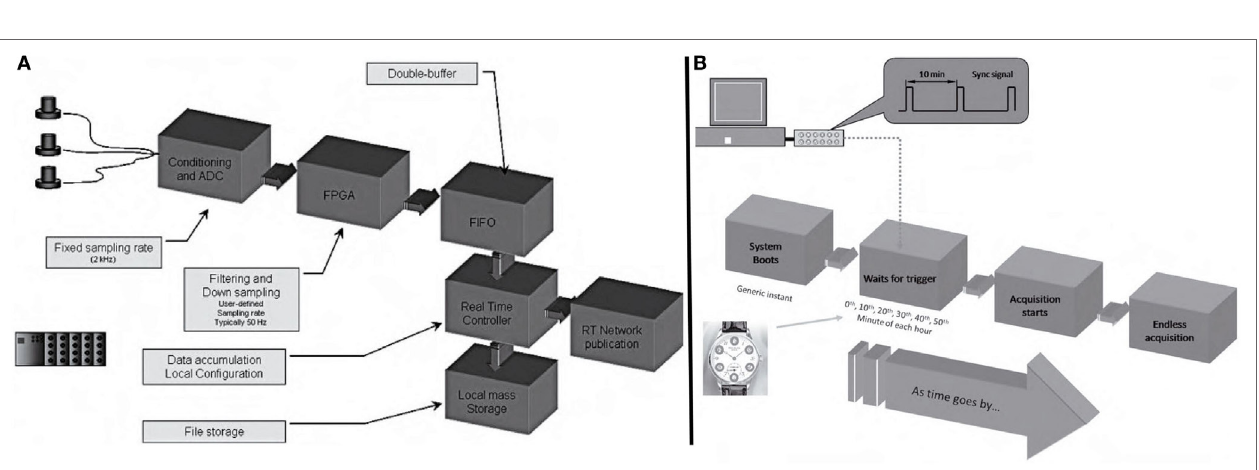
FiGURe 12 | (A) Representation of the network system and (B) sensors deployed in the stadium. Reprinted from (Cigada et al.,